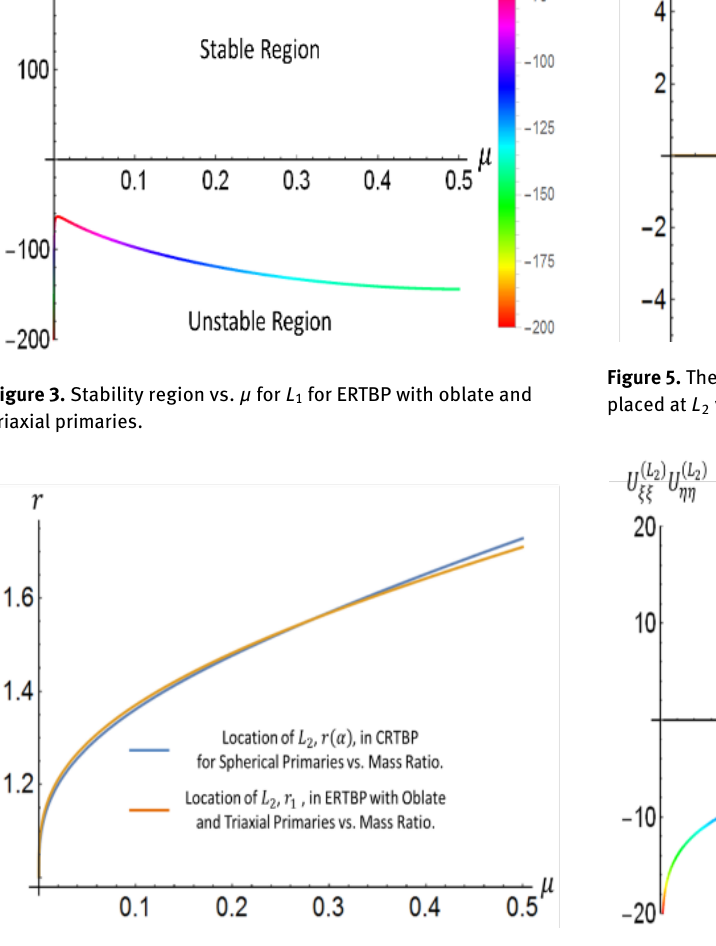
Figure 4. Location of L 2 vs. µ for two different cases, CRTBP for spherical primaries and ERTBP with oblate and triaxial primaries.